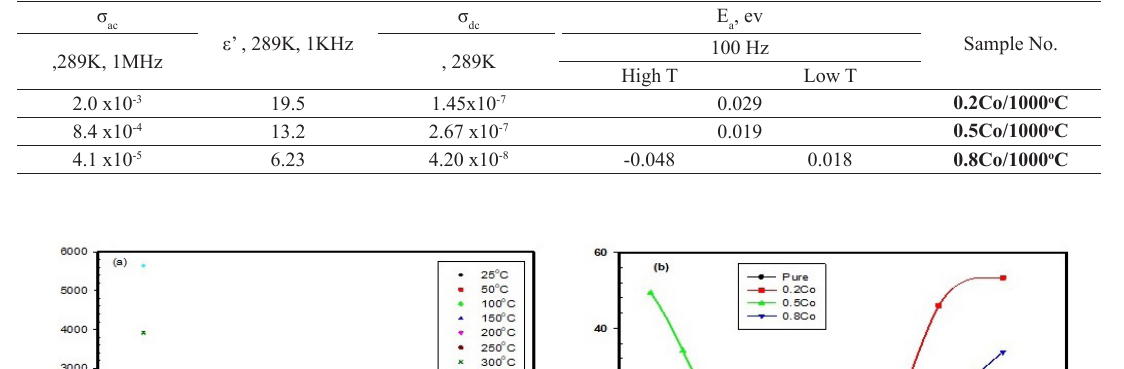
Figure 10b . The voltamograms look like that corresponding